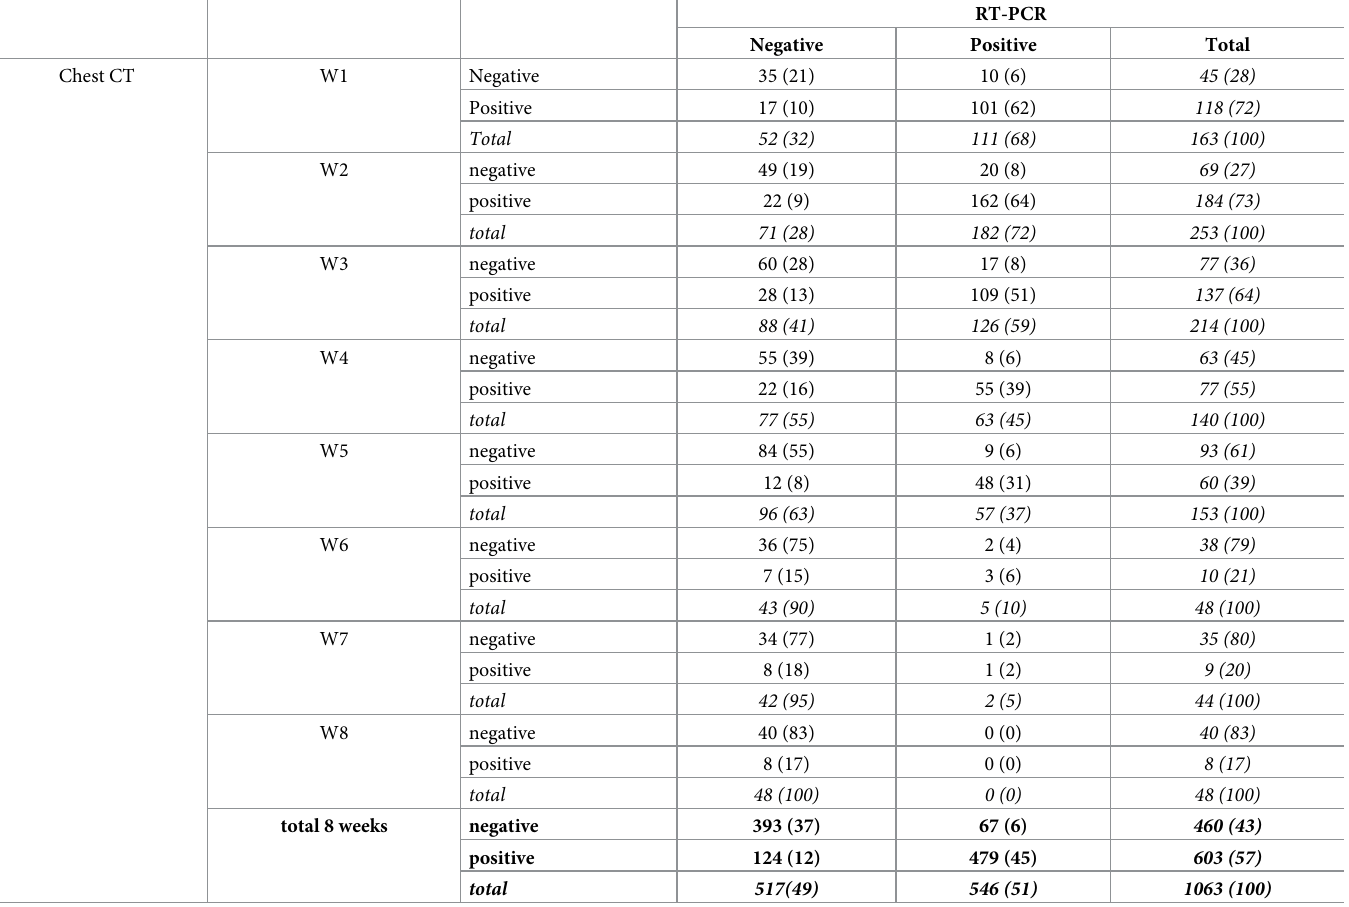
Table 2. Contingency table of the results of CT and RT-PCR for COVID-19 as a function of weeks from country-wide